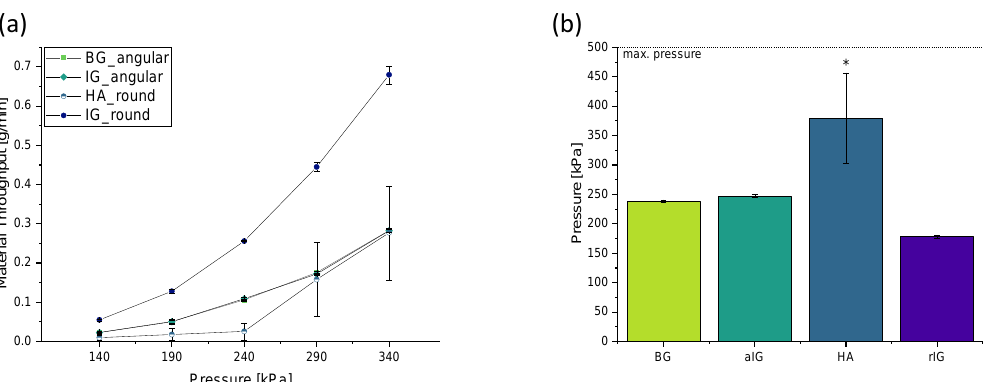
Figure 2. Material throughput of different round and angular particles in an alginate matrix at 5 different pressures, extruded for 1 min ( a ). Comparison of the pressures required to obtain the same material throughput as the reference ink based on angular BG at 240 kPa ( b ). One-way ANOVA statistical analysis indicates significant differences (* p < 0.05) of ink HA in relation to all other fillers. Especially the HA ink presented a significantly different trend compared to the inks with other fillers. A high variation resulting in a high standard deviation of the measured weights of the extruded material, especially at higher pressures, indicated a highly inho- mogeneous printing performance of the round HA filler particles in the used HA-alginate